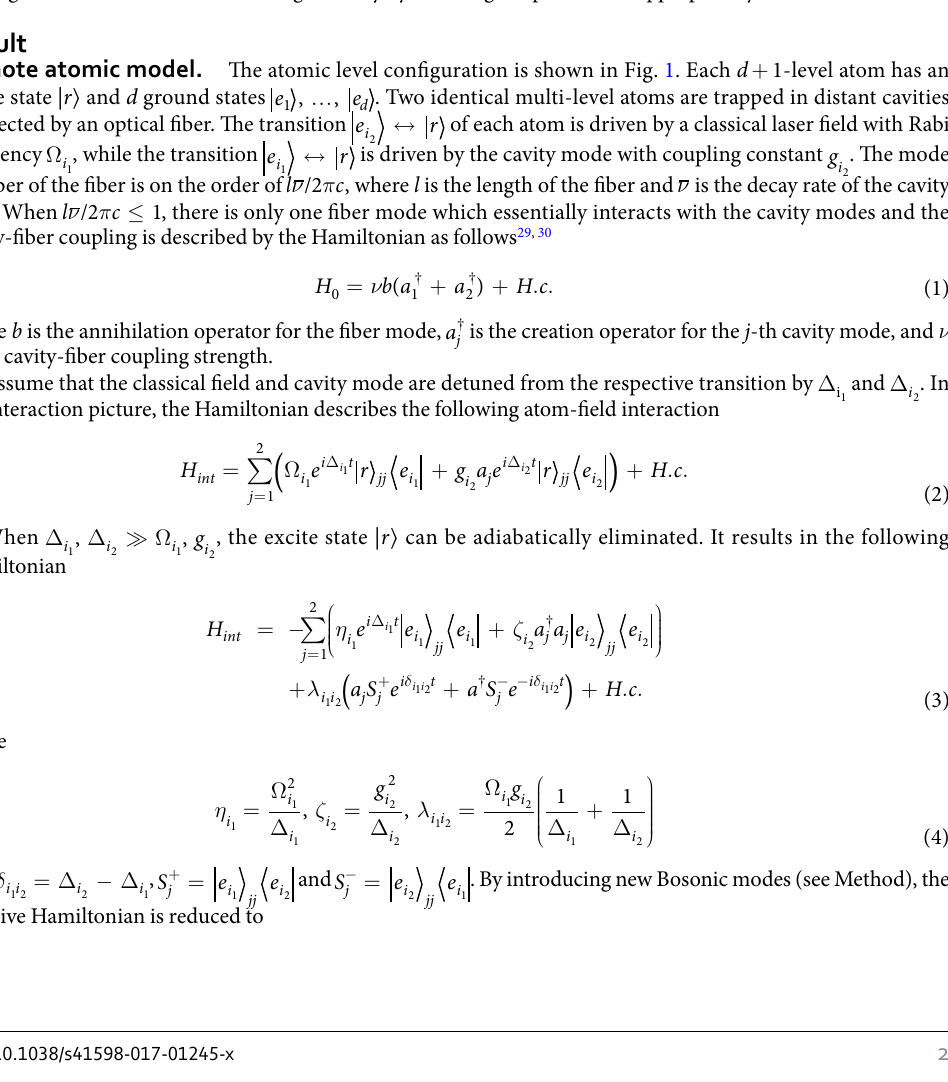
Figure 1. Involved atomic levels and transitions. The transition ↔ e r cavity mode with coupling constant g j and detuning Δ 2 . The transition ↔ e r and detuning Δ 1 with Rabi frequency Ω j